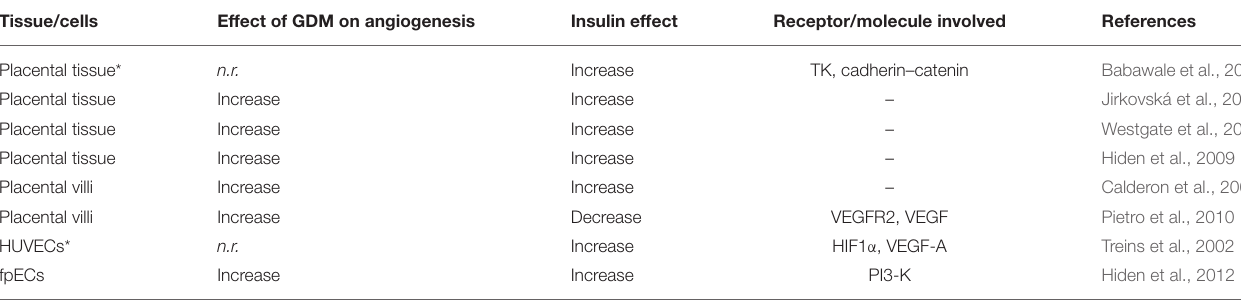
TABLE 2 | Effect of insulin on angiogenesis in the human fetoplacental vasculature in GDM. Tissue/cells Effect of GDM on angiogenesis Insulin effect Receptor/molecule